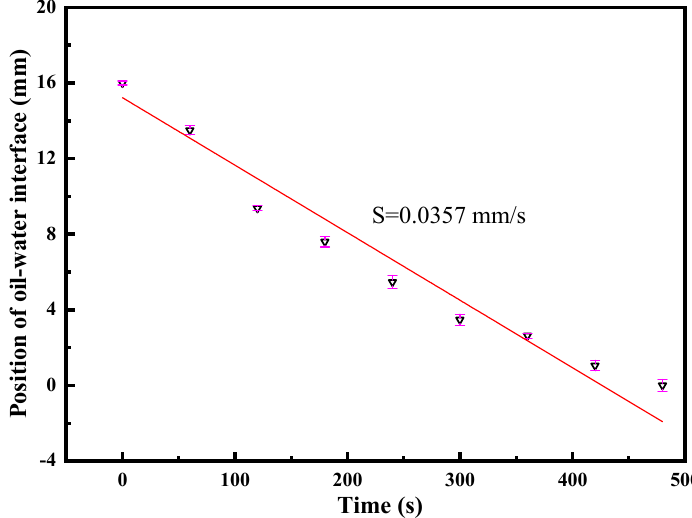
Figure 4. Graph depicting the position of the OWI around the well TK467 with time.